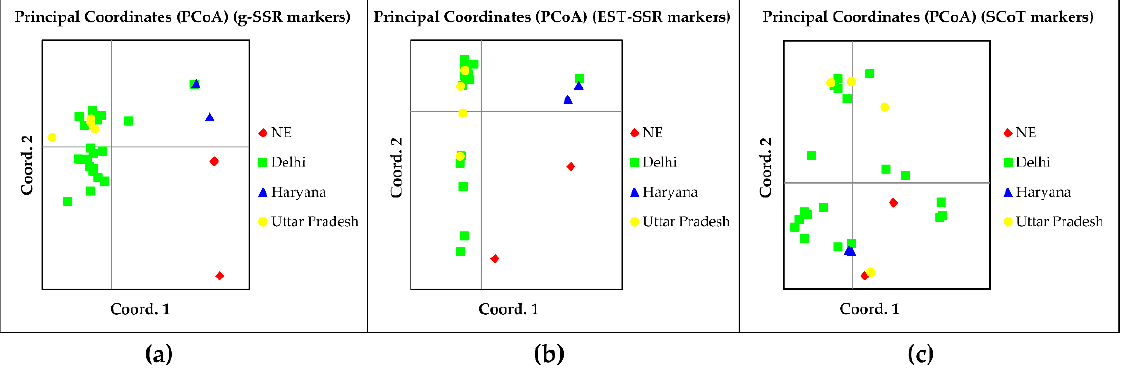
Figure 3. Principal Coordinate Analysis (PCoA) of 28 Tinospora accessions based on ( a ) g-SSR ( b ) EST-SSR ( c ) SCoT markers.